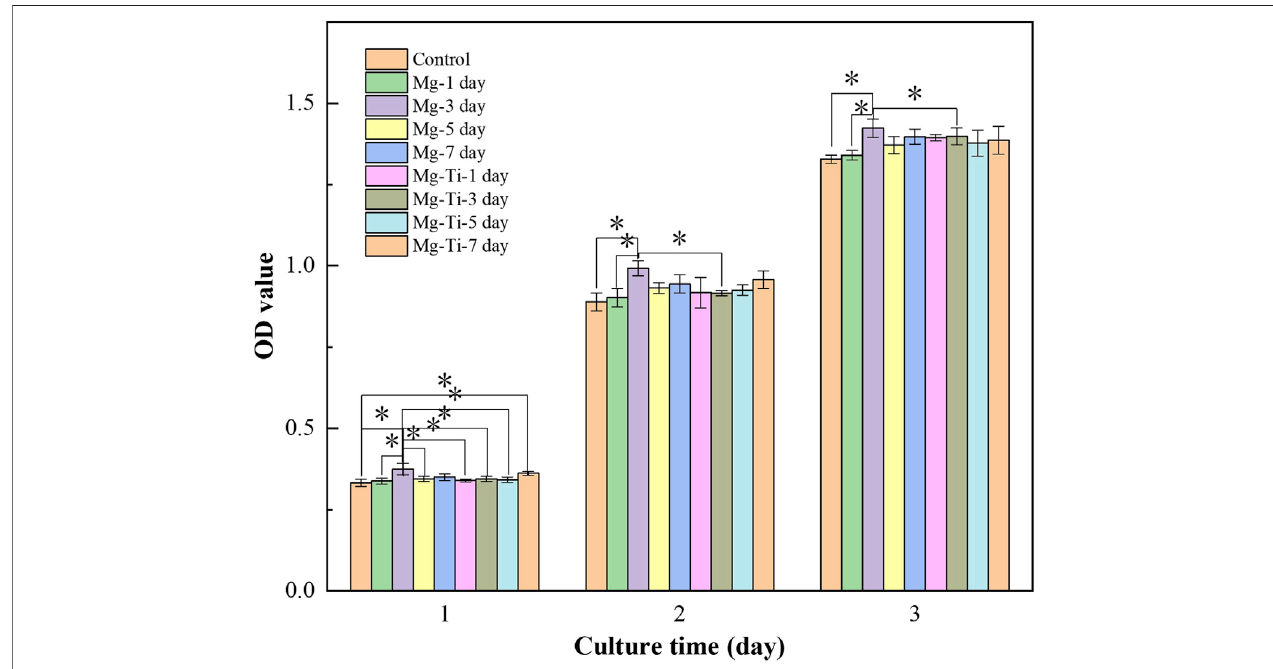
FIGURE 6 | Optical density value (OD value) of MC3T3-E1 cells cultured with extracts of the degraded Mg-Ti composite and pure Mg.